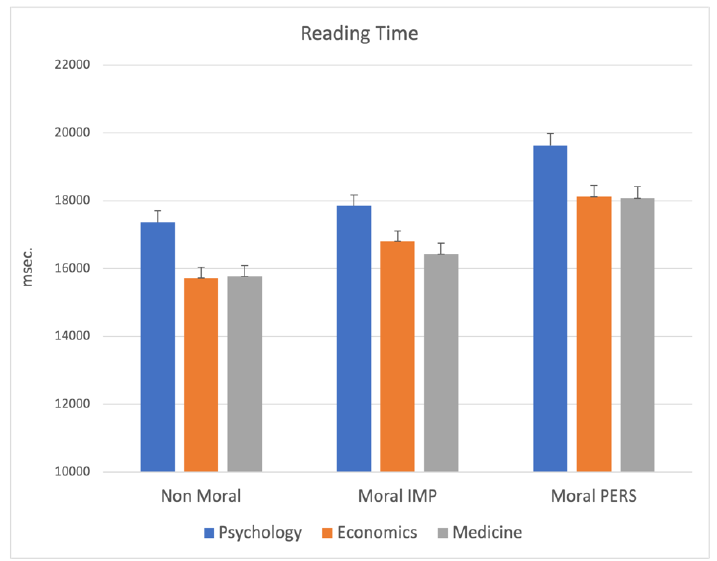
Figure 5. MANCOVA results on Reading Time: significant main effect for school. Note: the y-axis shows the Reading Time (msec.).